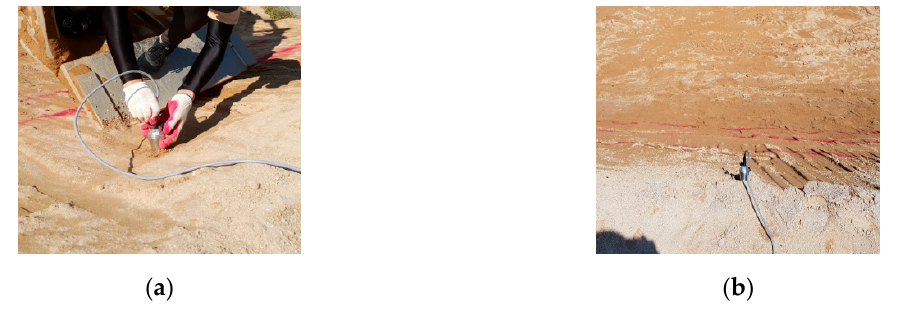
Figure 5. Installation of a sensor: ( a ) Penetration of the sensor into the model slope; ( b ) Connection of the sensor through a wire.